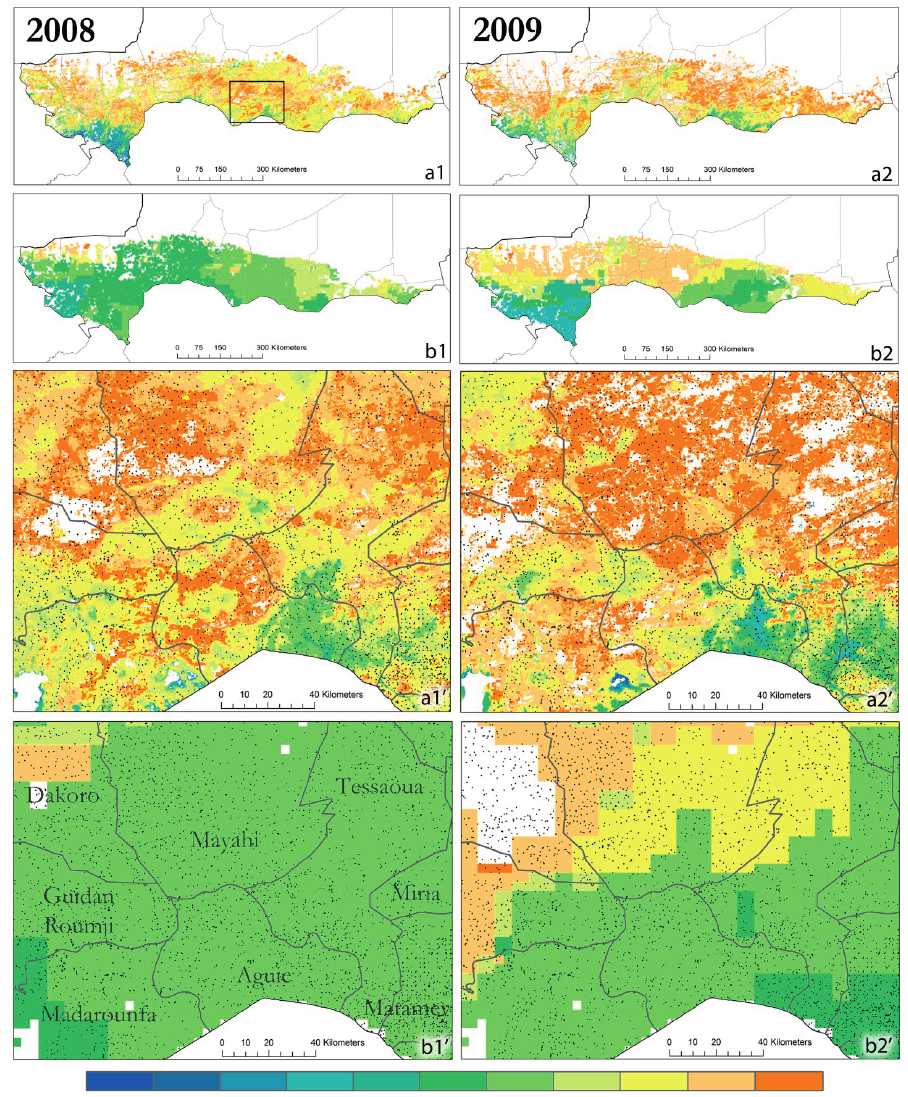
Figure 3. The dekad of the last green-up detection derived from MODIS for the whole country ( a1 ) for 2008 and ( a2 ) for 2009, and a zoom over Maradi region (see location box in a1) ( a1’ ) for 2008 and ( a2’ ) for 2009. The estimated sowing dekad derived from RFE for the whole country ( b1 ) for 2008 and ( b2 ) for 2009, and a zoom over Maradi region ( b1’ ) for 2008 and ( b2’ ) for 2009. The color white represents the areas where crops never started before 20 August. The black dots represent the